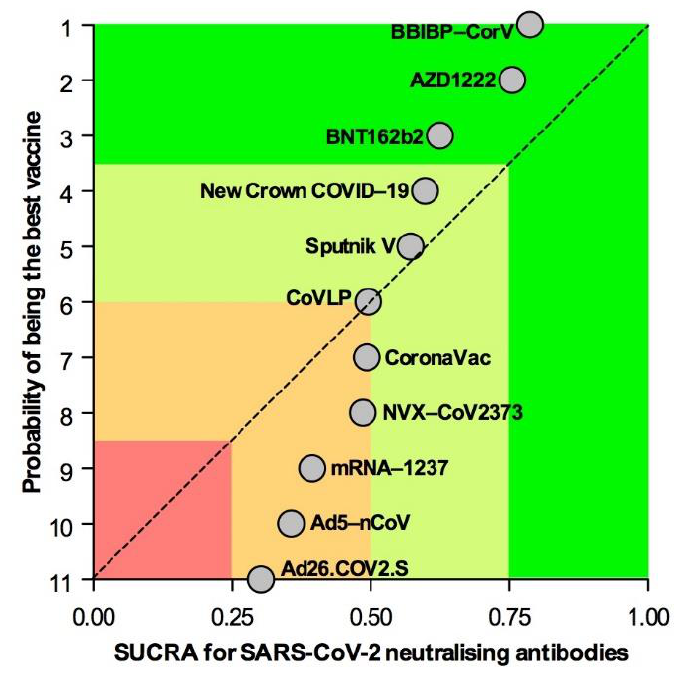
Figure 4. Overall ranking plot displaying the efficacy of candidate SARS-CoV-2 vaccines at inducing peak neutralizing antibody response. Vaccination strategies were plotted on the x axis according to SUCRA, where 1 results for a vaccine considered to be the best, and 0 for a vaccine considered to be the worst. SARS-CoV-2 vaccines were plotted on the y axis according to the rank probability of the best vaccine, where a score of 1 is assigned to the best vaccination strategy. SARS-CoV-2: severe acute respiratory syndrome coronavirus 2; SUCRA: surface under the cumulative ranking curve analysis.